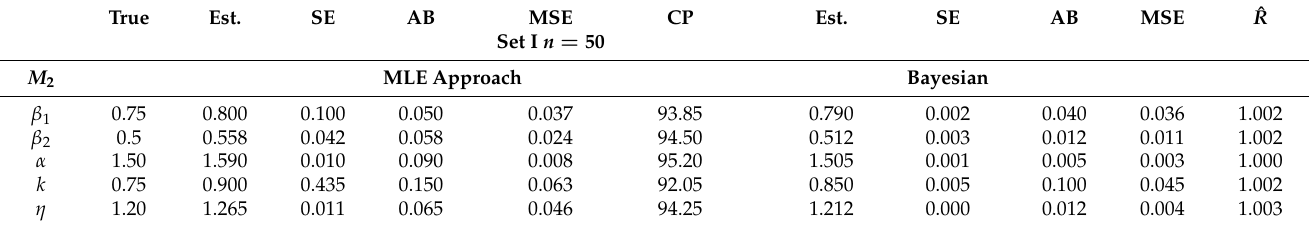
Table 1. Simulation study for GLL–AH regression model. True values (True), Estimates